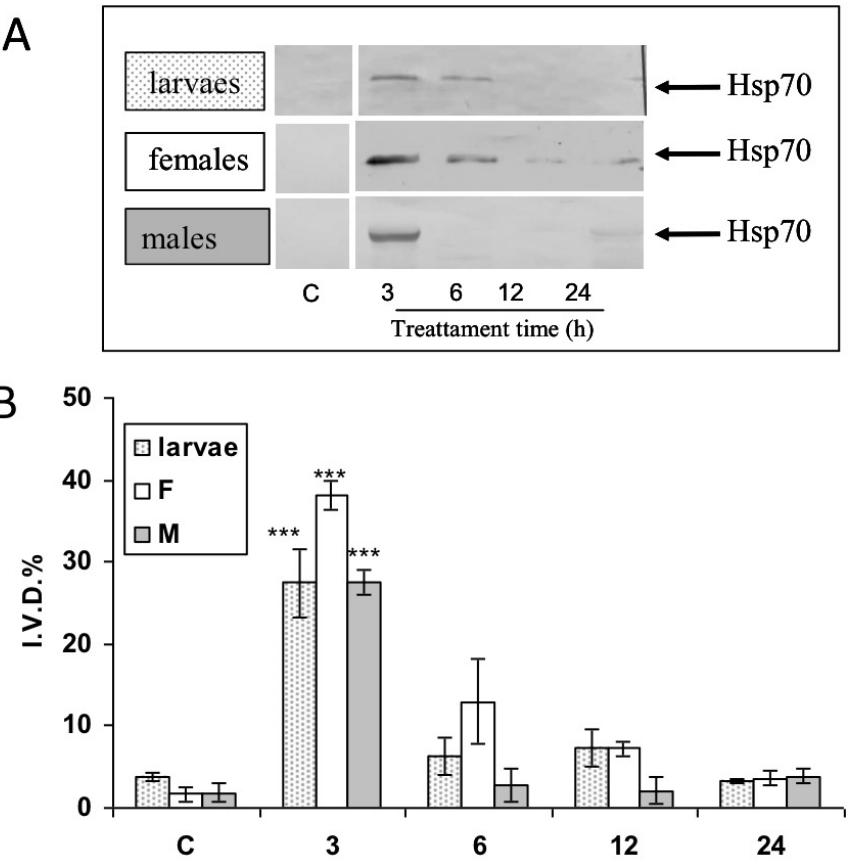
Figure 4. Effects of Bacillus thuringiensis on expression levels of the protein Hsp70 in adults and larvae of hemocites Rhynchophorus ferrugineus after 3, 6, 12, and 24 h treatment. ( A ) Representative Western blot of Hsp70 levels in three specimens from each group (one for each experimental trial). ( B ) Integrated optical density histogram (IDV) of the Hsp70 protein bands. Data are means ± S.D. (N = 15 control and N = 15 test specimens). Asterisks represent significant differences between control and test groups (*** p < 0.001).